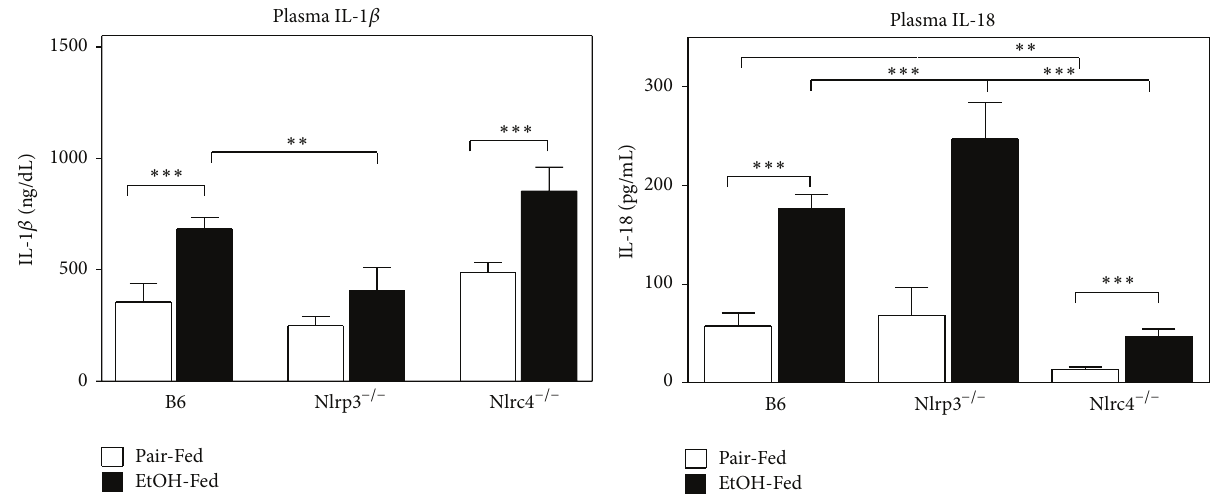
Figure 7: Altered IL-1 𝛽 and IL-18 expression in the liver in Nlrp 3 −/− and Nlrc 4 −/− mice. Protein was isolated from livers of C57BL/6J (B6), Nlrp 3 −/− , and Nlrc 4 −/− mice fed Lieber-DeCarli ethanol-containing diet (EtOH-Fed) or pair-fed controls (Pair-Fed). Levels of IL-1 𝛽 and IL-18 were measured using specific ELISA. Values represent the mean ± SEM with ∗∗ 𝑃 < 0.05 , ∗∗∗ 𝑃 < 0.001 by Student’s 𝑡 -test for 𝑛 = 4 –6 mice per